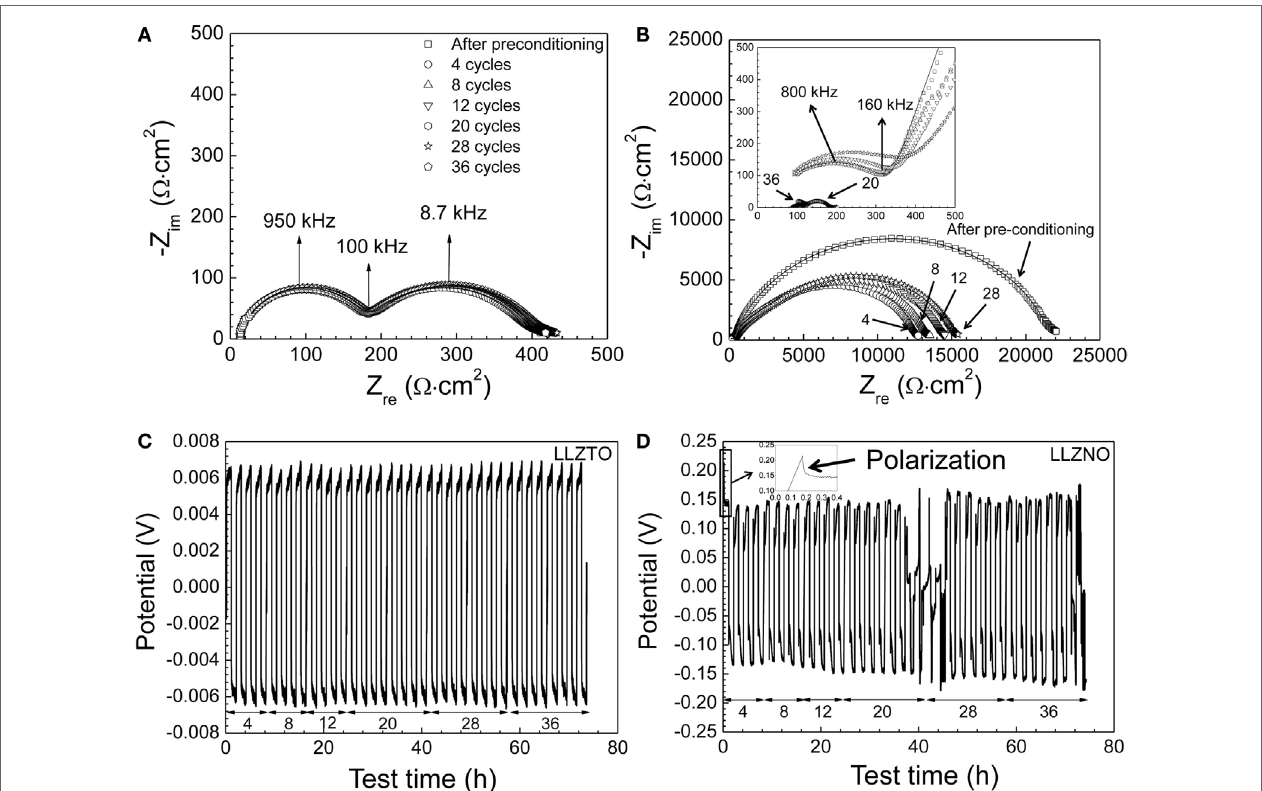
FigUre 4 | The impedance spectra with fitted line of (a) the li–li 6.5 la 3 Zr 1.5 Ta 0.5 O 12 –li cell and (B) the li–li 6.5 la 3 Zr 1.5 nb 0.5 O 12 –li cell as a function of the Dc cycling (0, 4, 8, 12, 28, and 36 cycles) at 23.5 ± 1°c, respectively . Since the complexity of the modeling with the Li 6.5 La 3 Zr 1.5 Nb 0.5 O 12 after 4 DC cycles, the modeling with LLZNO was not performed during the cycling tests. The results of the DC cycling for Li–Li 6.5 La 3 Zr 1.5 Ta 0.5 O 12 –Li (c) and for Li–Li 6.5 La 3 Zr 1.5 Nb 0.5 O 12 –Li (D) with the 0.01 mA/cm 2 at 23.5 ± 1°C were plotted, respectively. The number of DC cycles was noted below the DC cycling